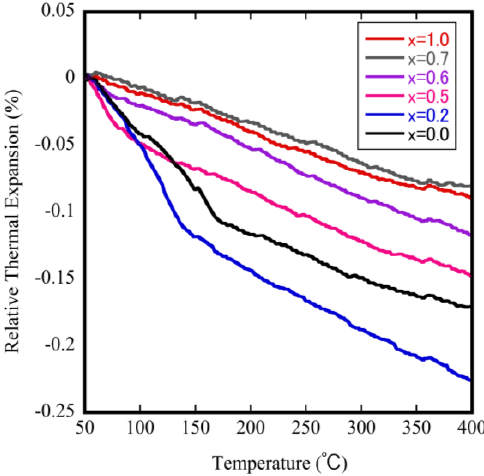
Figure 6. Thermodynamic analyzer (TMA) results for ZrW 2− x Mo x O 8 sintered bodies.